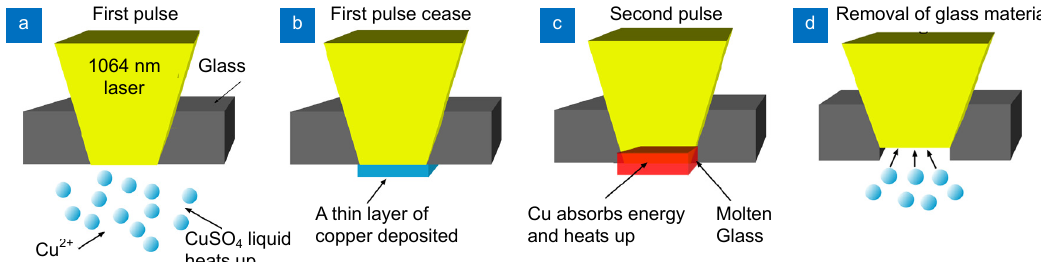
Fig. 6 | Proposed mechanism of the glass cutting using 1064 nm laser irradiation. ( a ) Laser irradiates from the top. ( b ) Copper deposition on the underneath of the glass. ( c ) The deposited copper absorbs the laser energy and heats up the immediate glass region. ( d ) Removal of the molten glass. Figure reprinted with permission from ref. 61 , Springer-Verlag.